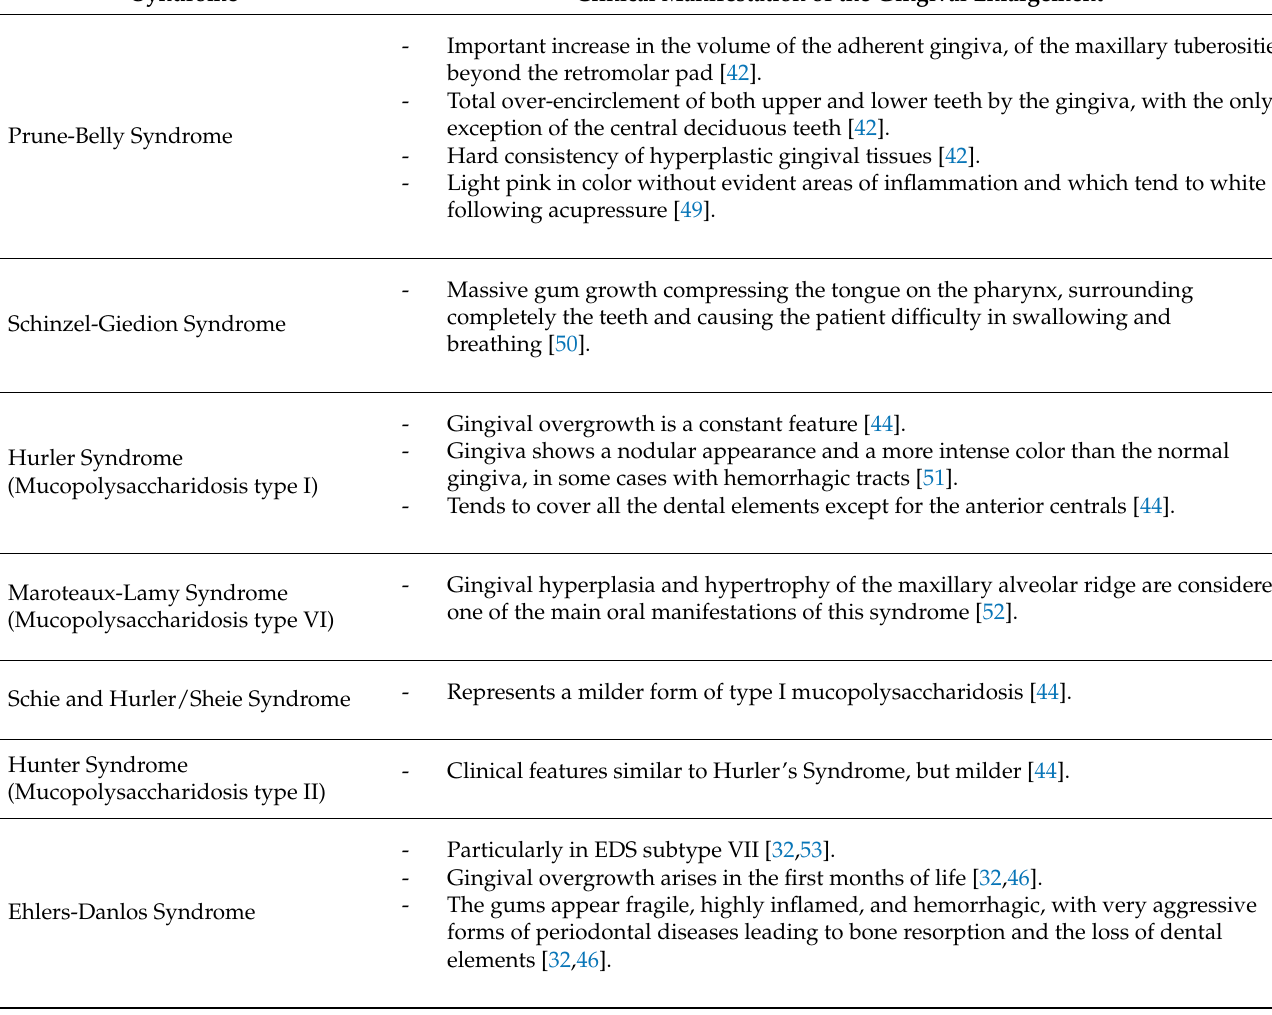
Table 2. Syndromes related to gingival